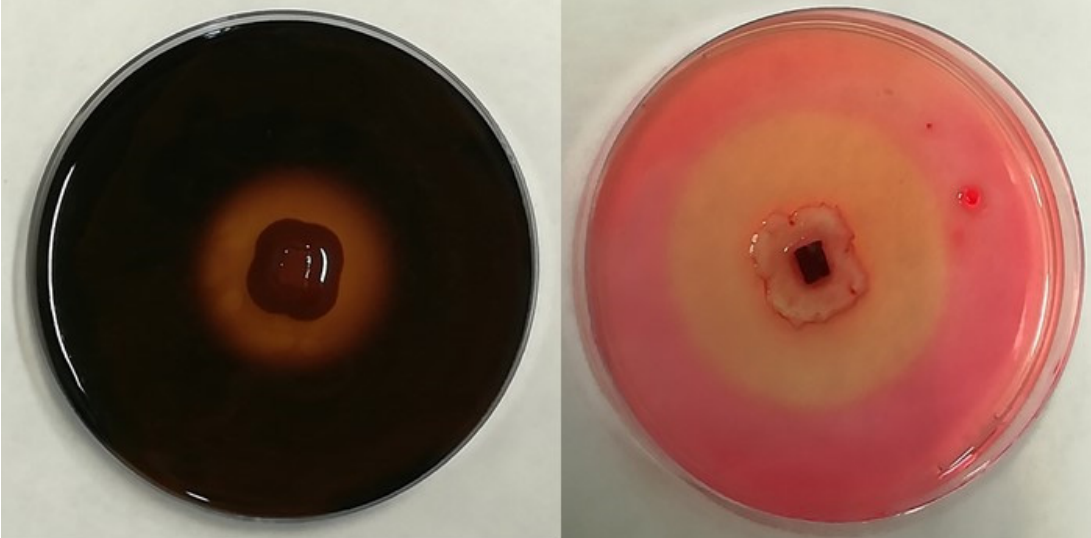
Figure 1. Examples of the hydrolysis halo observed in the present study for positive results of amylolytic activity ( left ) and cellulolytic activity ( right ).